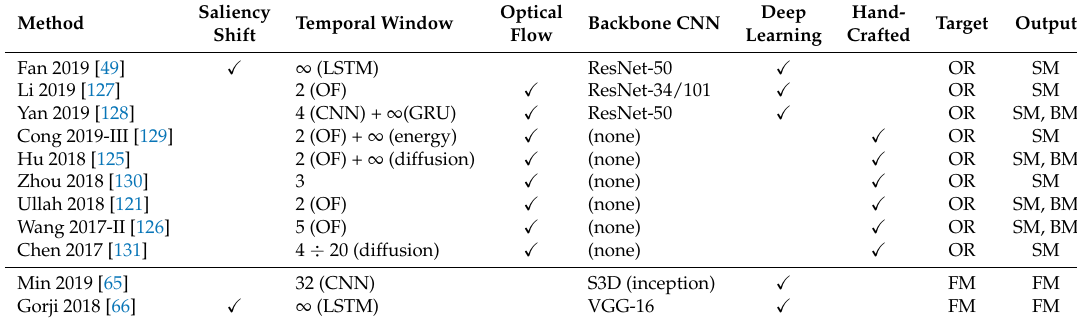
Table 9. Methods for video saliency. The temporal window is indicated in relation to the underlying technique: OF (Optical Flow), LSTM (Long-Short Term Memory), CNN (Convolutional Neural Network), GRU (Gated Recurrent Unit). The “Target” column indicates the nature of the ground truth used to train or develop the methods, while “Output” describes what data they explicitly generate (OR = Object Regions, SM = Sharp Maps, BM = Binary Masks, FM = Fixation